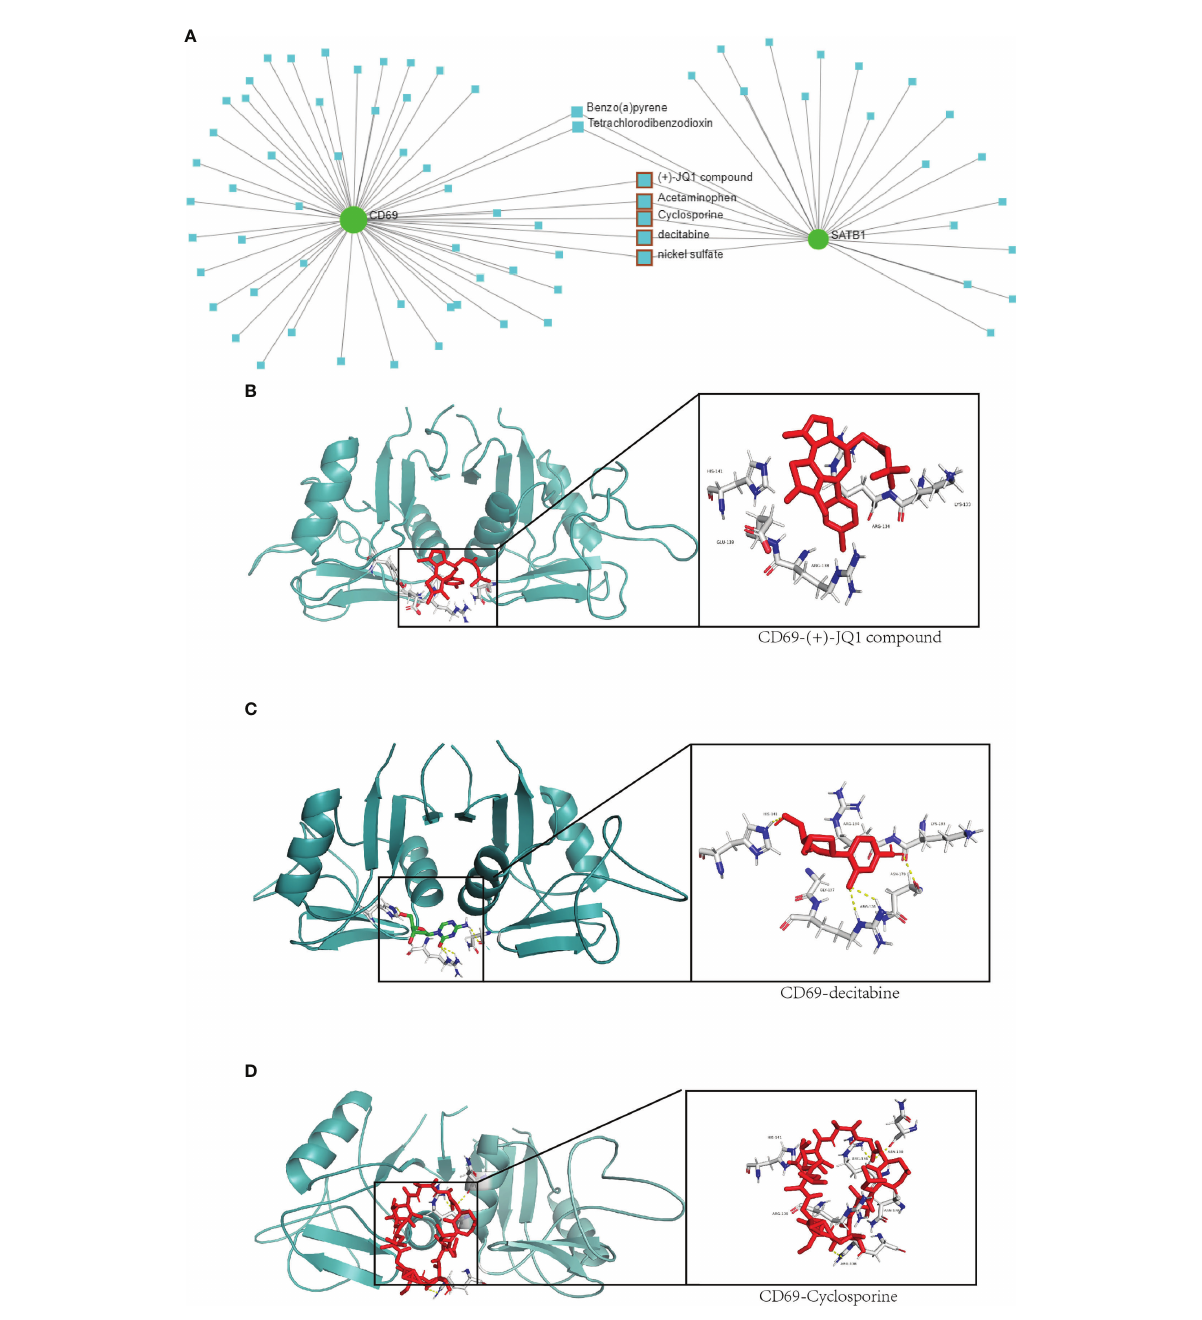
FIGURE 9 Drug network and molecular docking. (A) Compounds that may act on CD69 and SATB1 genes are predicted in the network analysis database. The compounds with therapeutic effects are selected by the red squares. (B – D) Molecular docking of CD69 and JQ1, decitabine and cyclosporine compounds. The protein structure of CD69 is in green, and the structure of the compound and its hydrogen-bonding site with CD69 is on the